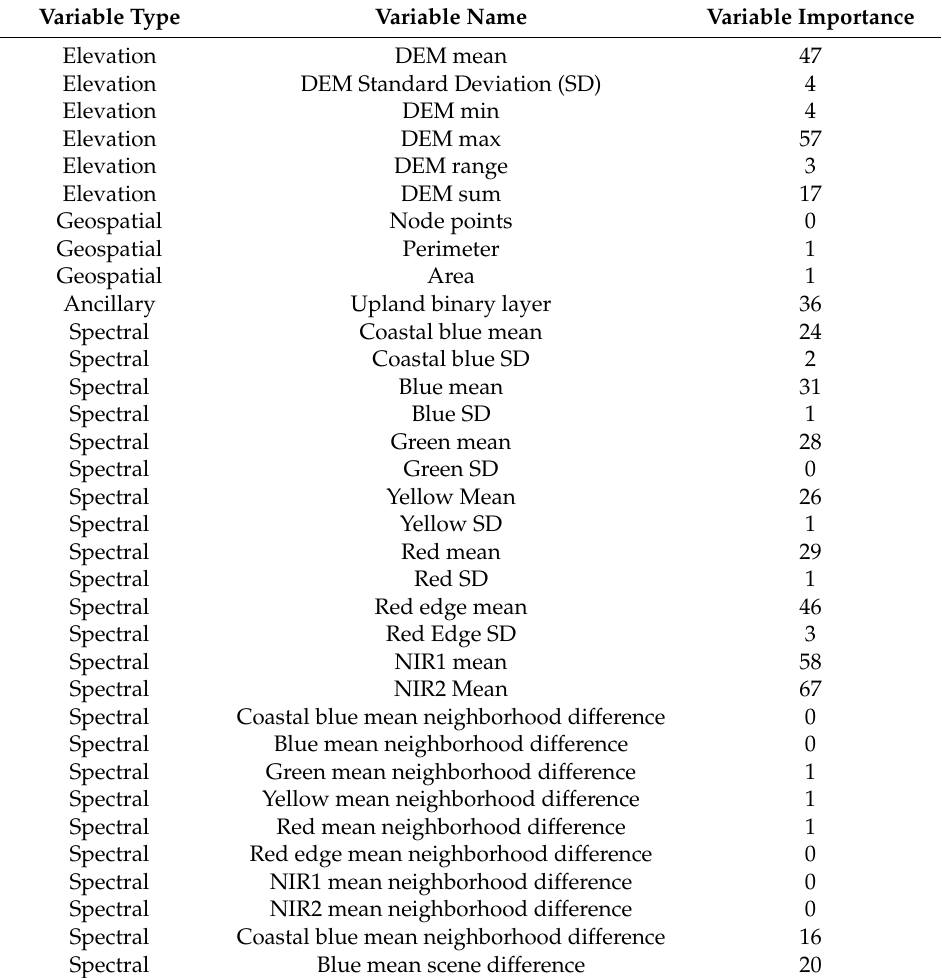
Table A3. Object parameters used in OBIA for 2012 and 2013 Worldview-2 imagery